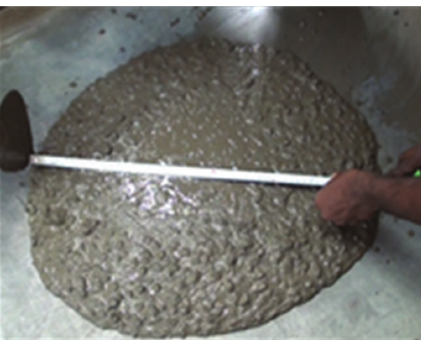
Figure 3: Slump flow